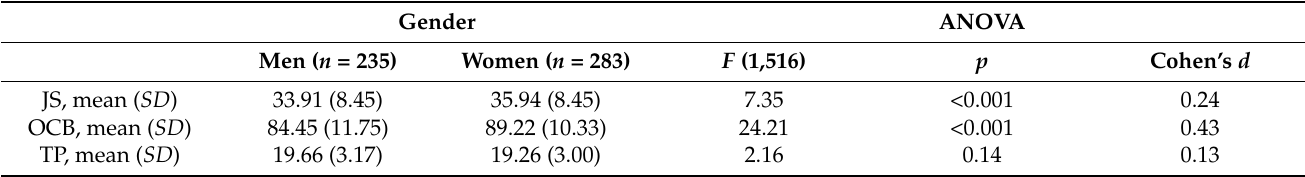
Table 3. Gender differences in psychological variables.